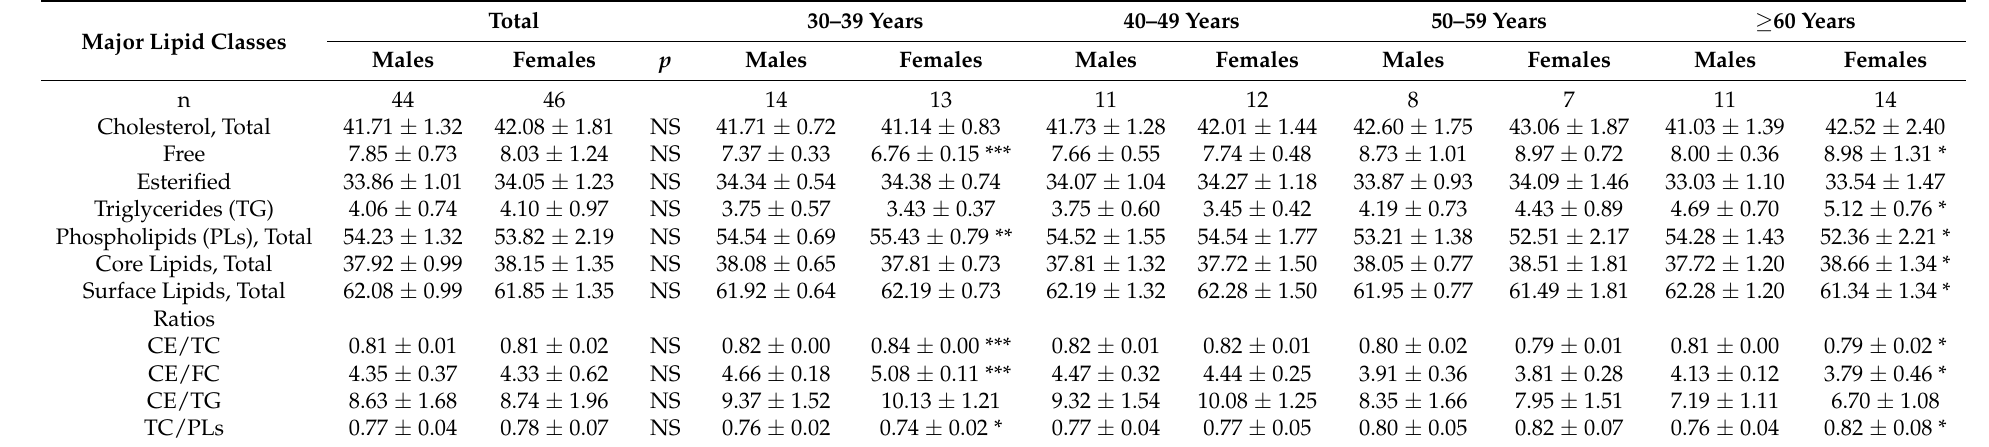
Table 5. Effect of gender on the HDL major lipid classes in the healthy